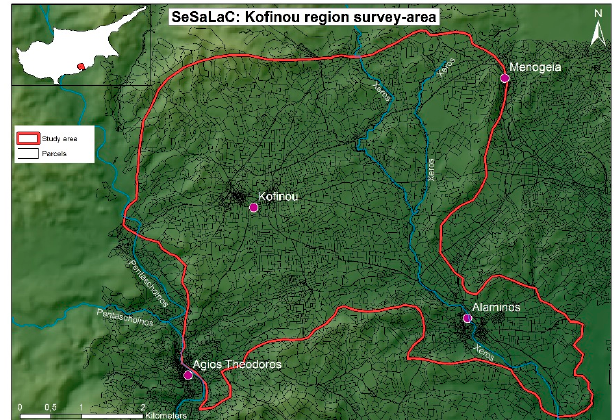
Figure 6. The survey area of the ‘Settled and Sacred Landscapes of Cyprus’ Project (SeSaLaC) in the Xeros valley, Larnaca District. Image© SeSaLaC (digital geological data courtesy of the Geological Survey Department, Republic of Cyprus; map drafted by V. Trigkas).